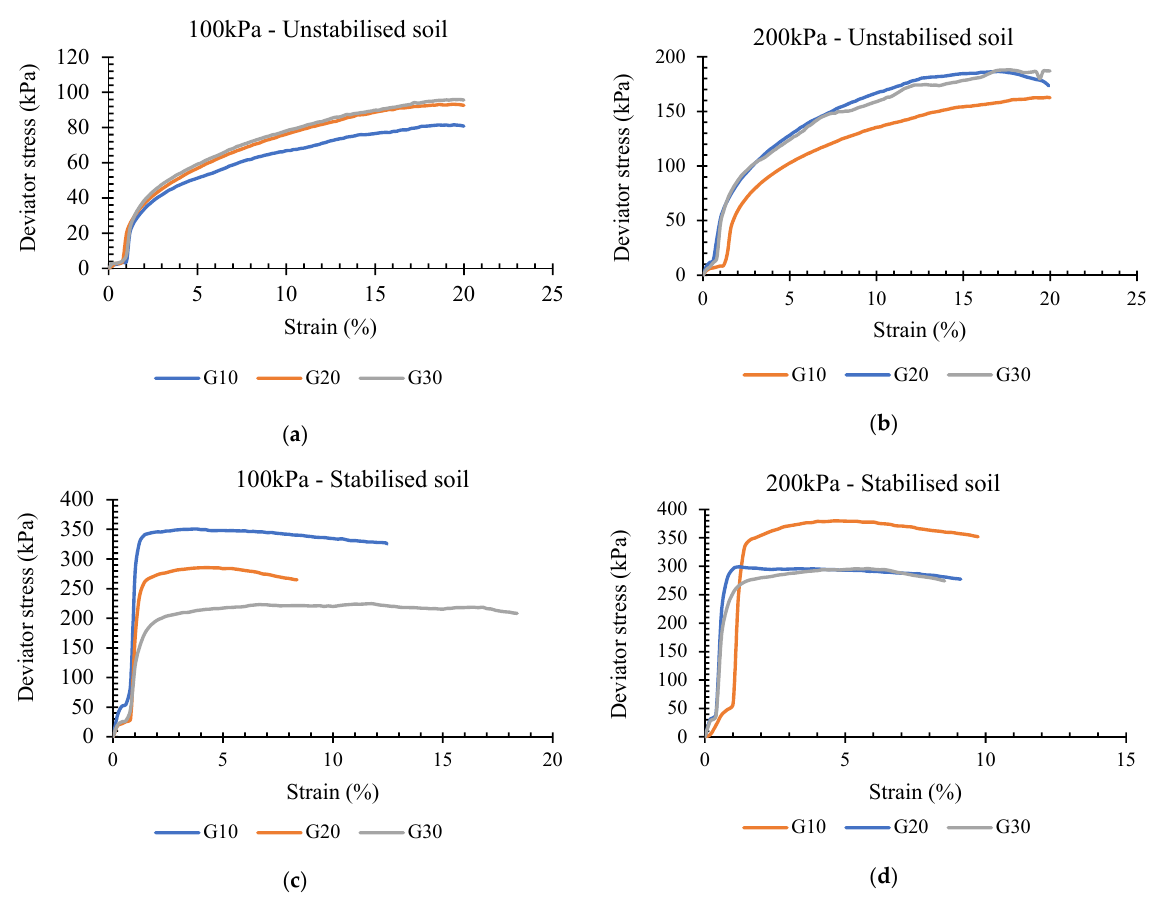
Figure 4. Stress–strain curves: ( a ) unstabilised soil under 100 kPa constant effective pressure; ( b ) unstabilised soil under 200 kPa constant effective pressure; ( c ) stabilised soil under 100 kPa constant effective pressure; ( d ) stabilised soil under 200 kPa constant effective pressure.